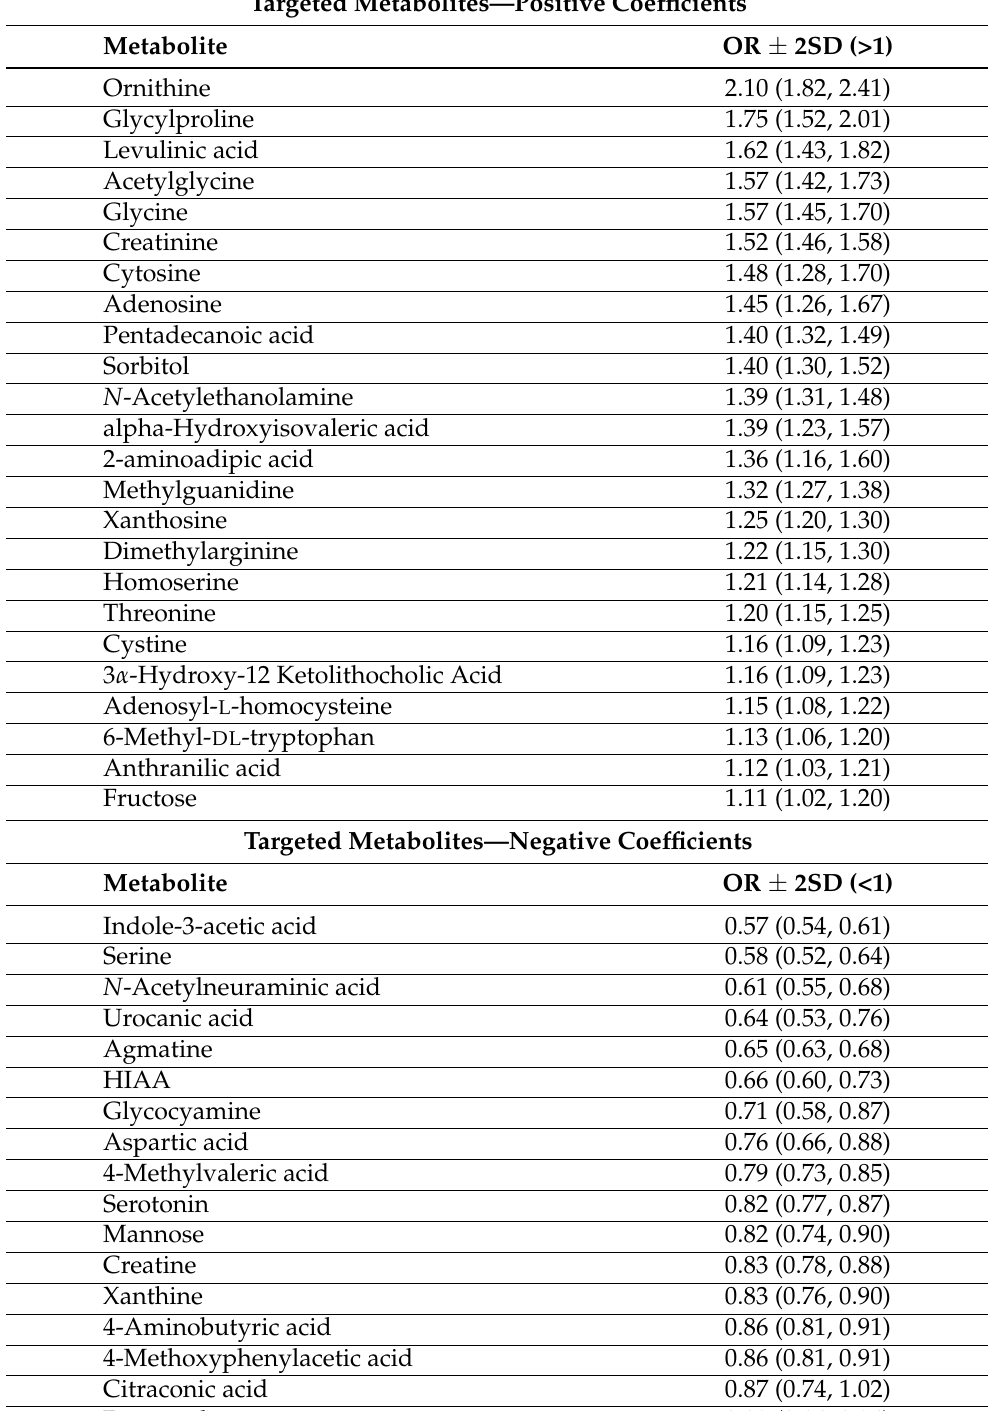
Table 3. Names and OR for targeted metabolites and lipids retained in all five elastic net models fit on the full data to classify PD patients against controls. Only ORs with magnitude greater than 1.1 or less than 0.9 are shown here. A two standard deviation interval is shown for the OR to quantify variability across the five missing data